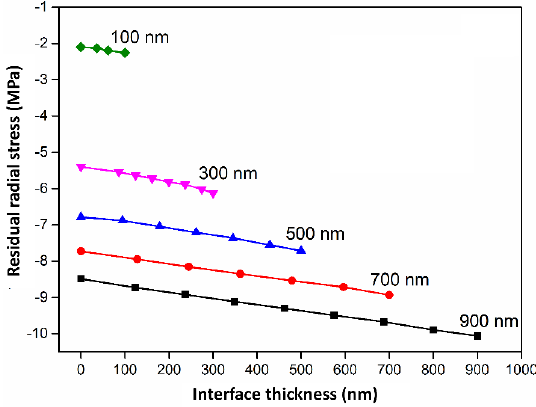
Figure 9. Distribution of residual stress, σ RR at 1300 ◦ C with di ff erent interface thickness.